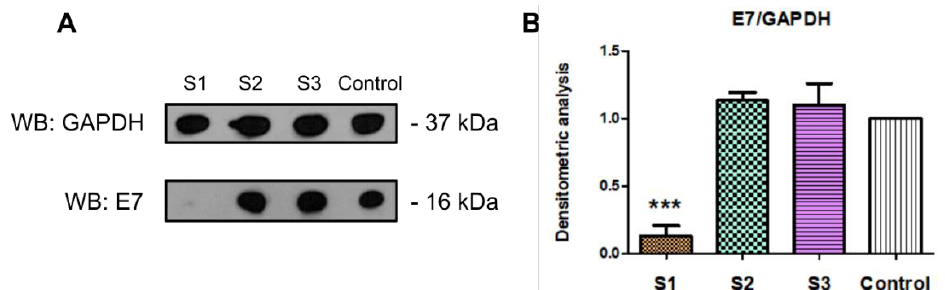
Figure 8. Effect of crude C. majus latex (S1), protein fraction (S2), and alkaloid-rich fraction (S3) on the expression of the viral E7 oncogene at the protein level in HeLa cells. Non-toxic concentrations of crude latex, alkaloid-rich fraction, and protein fraction were administered on HeLa cells. After 48 h of incubation, proteins were isolated, which were then separated by SDS-PAGE. Immunodetection of the E6 protein and the GAPDH as a reference protein was performed using the Western blot and specific antibodies. The densitometric measurement showed that only the crude C. majus latex reduced the level of HPV E7 proteins in HeLa cells (a reduction of 86.6%). The alkaloid-rich fraction and the protein fraction had no effect on the level of E7 protein synthesis. S1 — cells treated with crude latex, S2 — cells treated with the protein fraction, S3 — cells treated with the alkaloid-rich fraction, Control — untreated cells. ( A ) Representative Western blot of protein immunodetection. ( B ) Densitometric analysis using ImageJ software (NIH). *** p < 0.001.